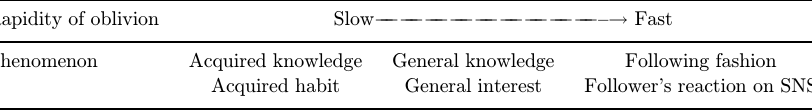
Table 1. Spectrum for the various phenomena relating to